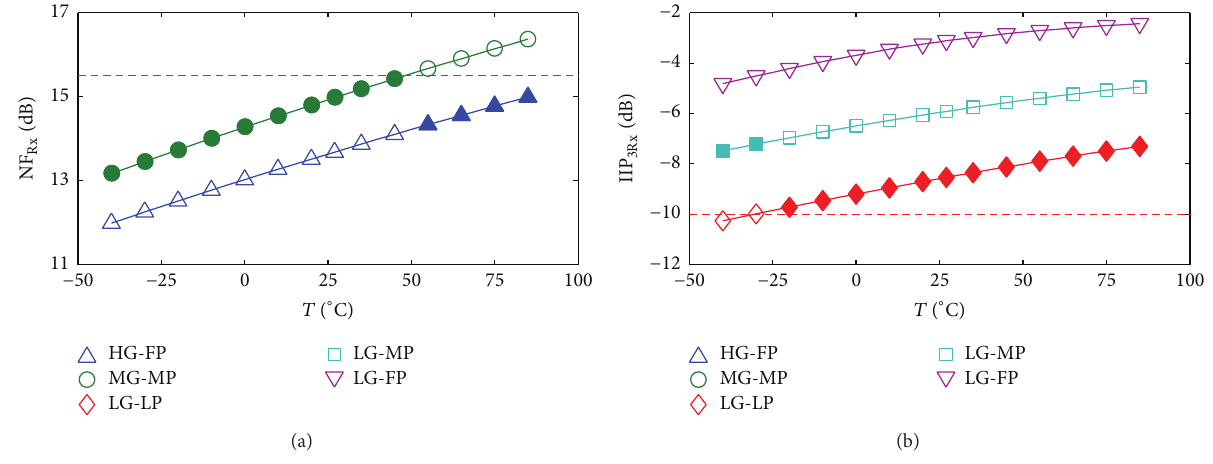
Figure 6: Receiver’s NF (a) and IIP 3 (b) under LNA temperature